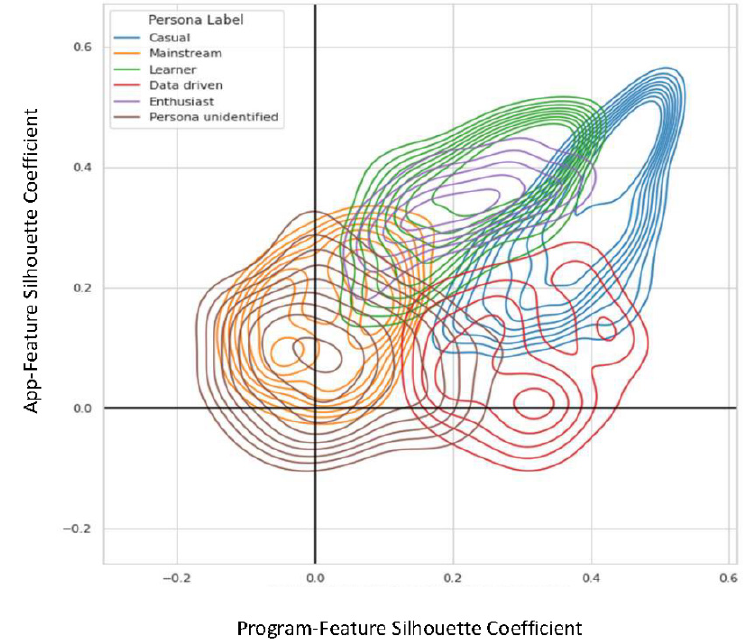
Figure 4. Kernel density estimation plot of the bivariate distribution of silhouette coefficients for each engagement persona. Members without an identified engagement persona (brown) had lower silhouette coefficients than those with an identified engagement persona.